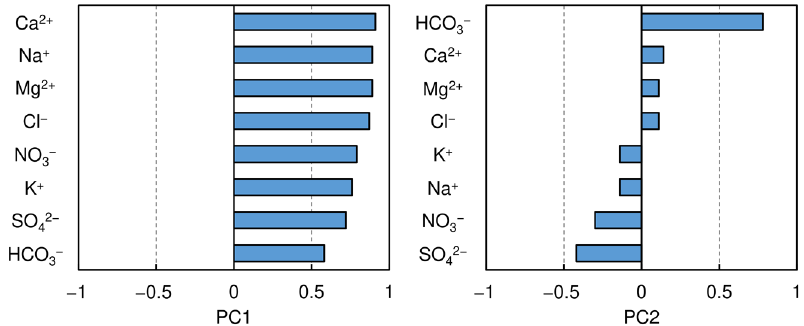
Figure 7. Relationship between extracted principal components (PCs) and ions.